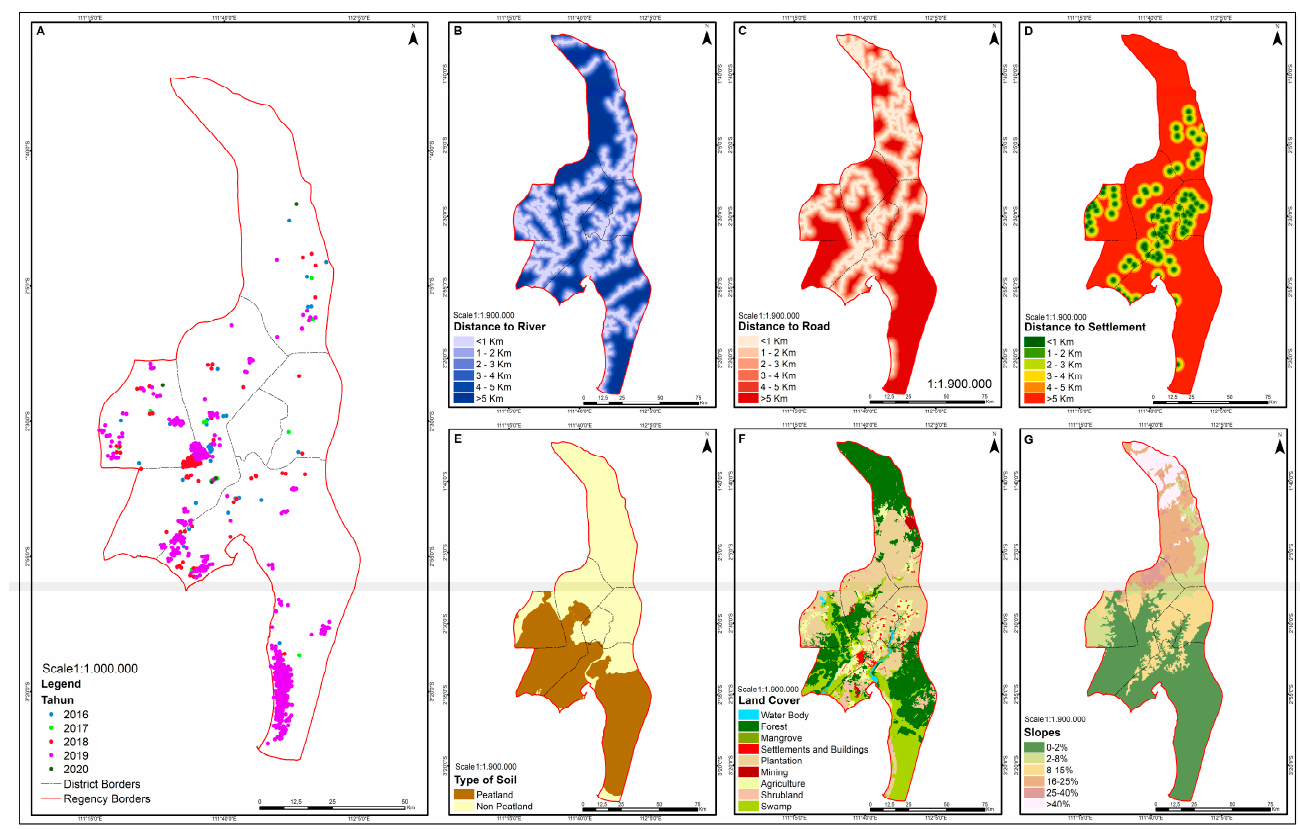
Figure 3. Datasets for modeling ( A ) hotspots in 2016–2020 ( B ) bu ff er of distance to river ( C ) bu ff er of distance to road ( D ) bu ff er of distance to se tt lement ( E ) type of soil ( F ) land covers ( G ) slopes.